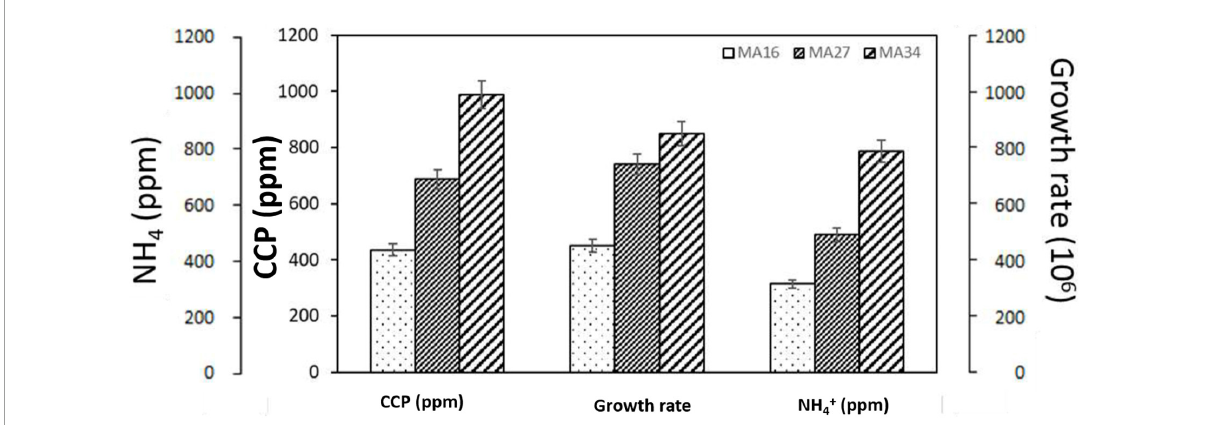
FIGURE2 Calcium carbonate precipitation (CCP) and production of urease by the selected calcium carbonate precipitating bacteria, Bacillus lichenforms (MA16), Bacillus megaterium (MA27), and Bacillus subtilis (MA34). Urease activity was measured as the concentration of the produced ammonium ions (NH 4 + ).